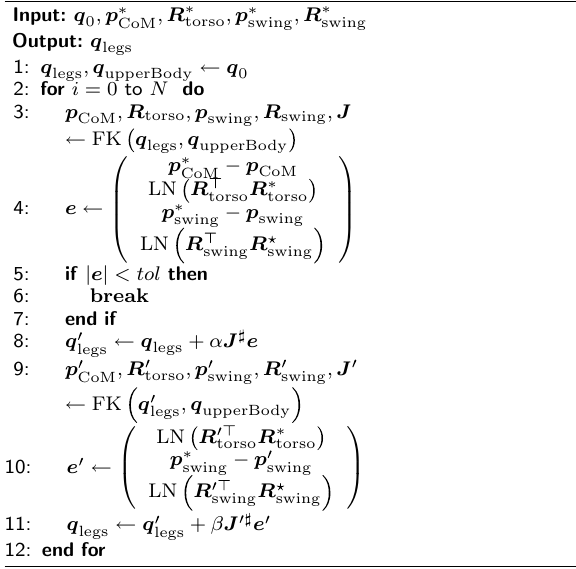
Algorithm 2 Inverse Kinematics for both legs